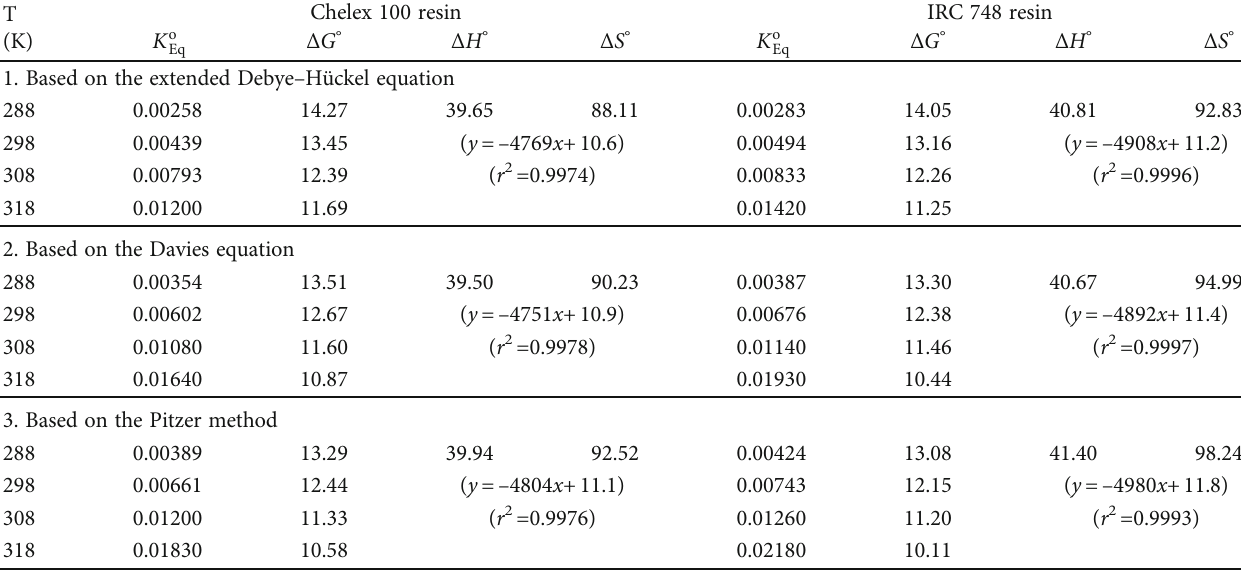
Table 1: Thermodynamic parameters for the process of Cu 2+ adsorption by two resins (Chelex 100 and IRC 748)